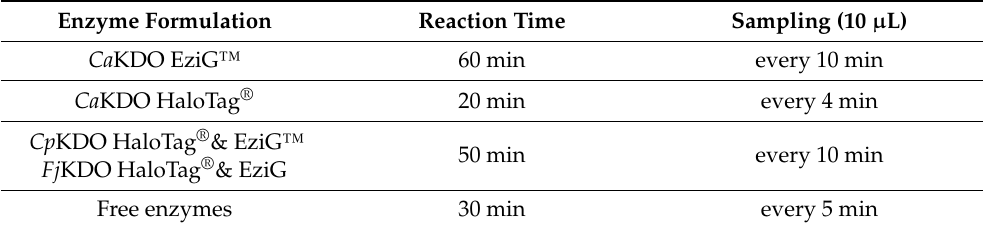
Table 2. Assay conditions for respective enzymes and